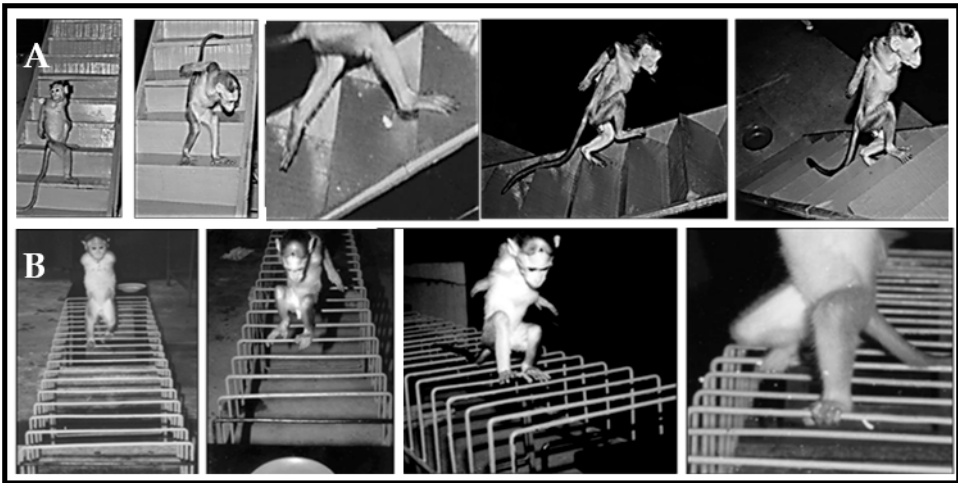
Figure 2. Locomotor behavior of trained Bonnet monkeys in ( A ) staircase runways and ( B ) grid runway. In staircase and grid runways, trained monkeys performed bipedal locomotion to receive the food rewards placed on either end of runways.